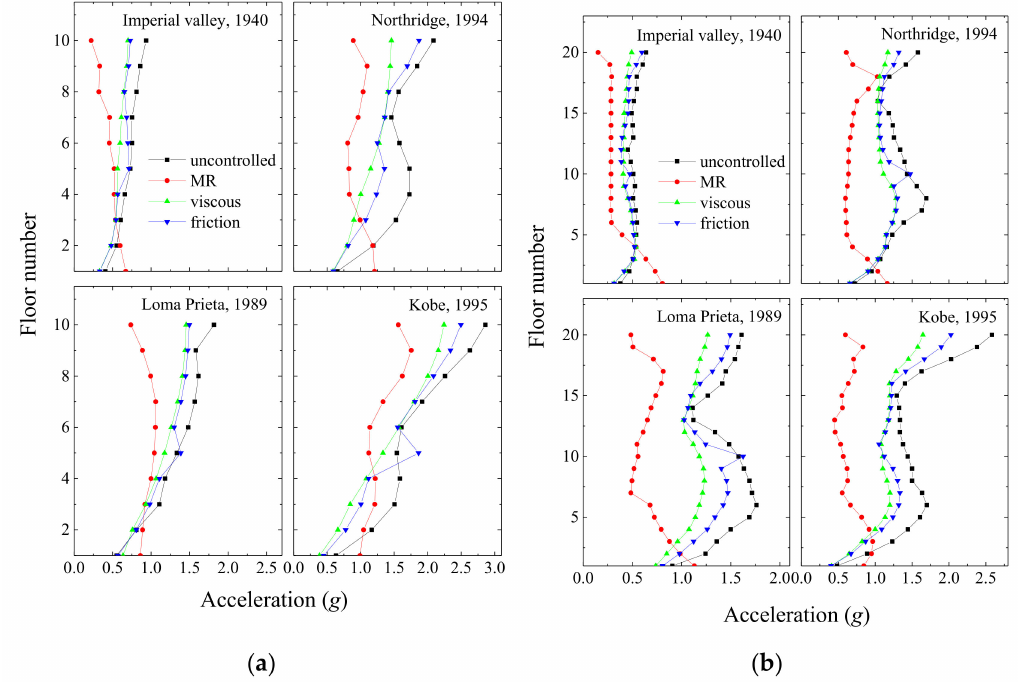
Figure 18. Peak floor acceleration response of: ( a ) a coupled stiff building and ( b ) a coupled flexible building when they are connected with different types of dampers arranged in Configuration